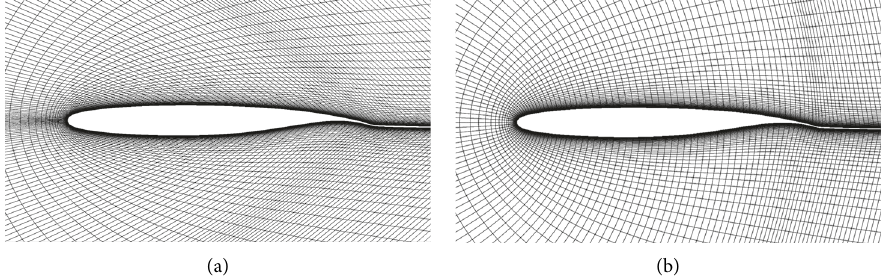
Figure 12: Closeup of the Navier–Stokes meshes optimized without curvature functions. (a) Optimized without orthogonality functions. (b) Optimized with orthogonality functions.